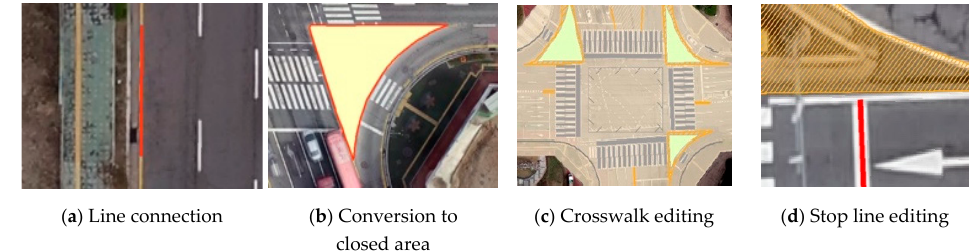
Figure 5. Detailed editing of a high-precision digital map.